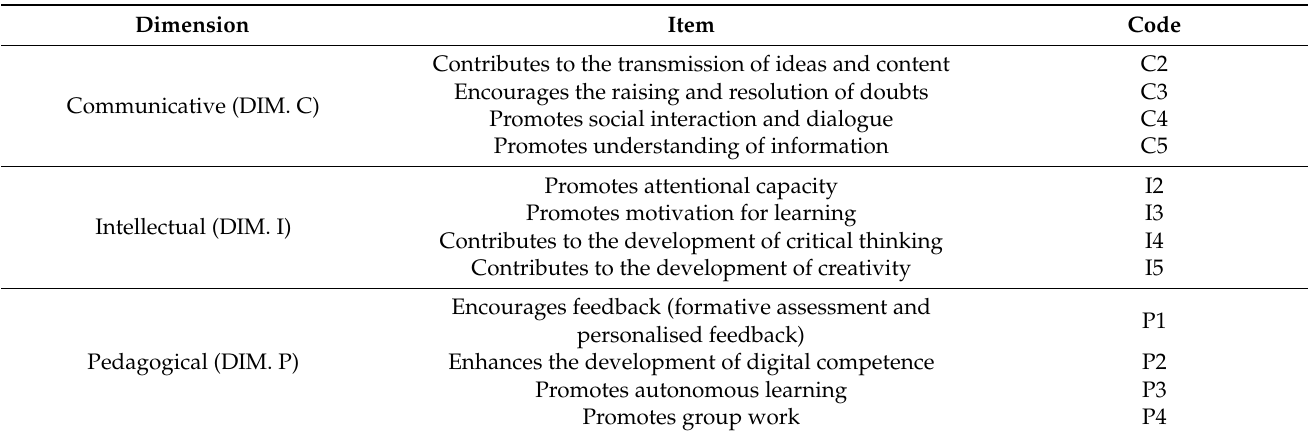
Table 2. Dimensions and items of the